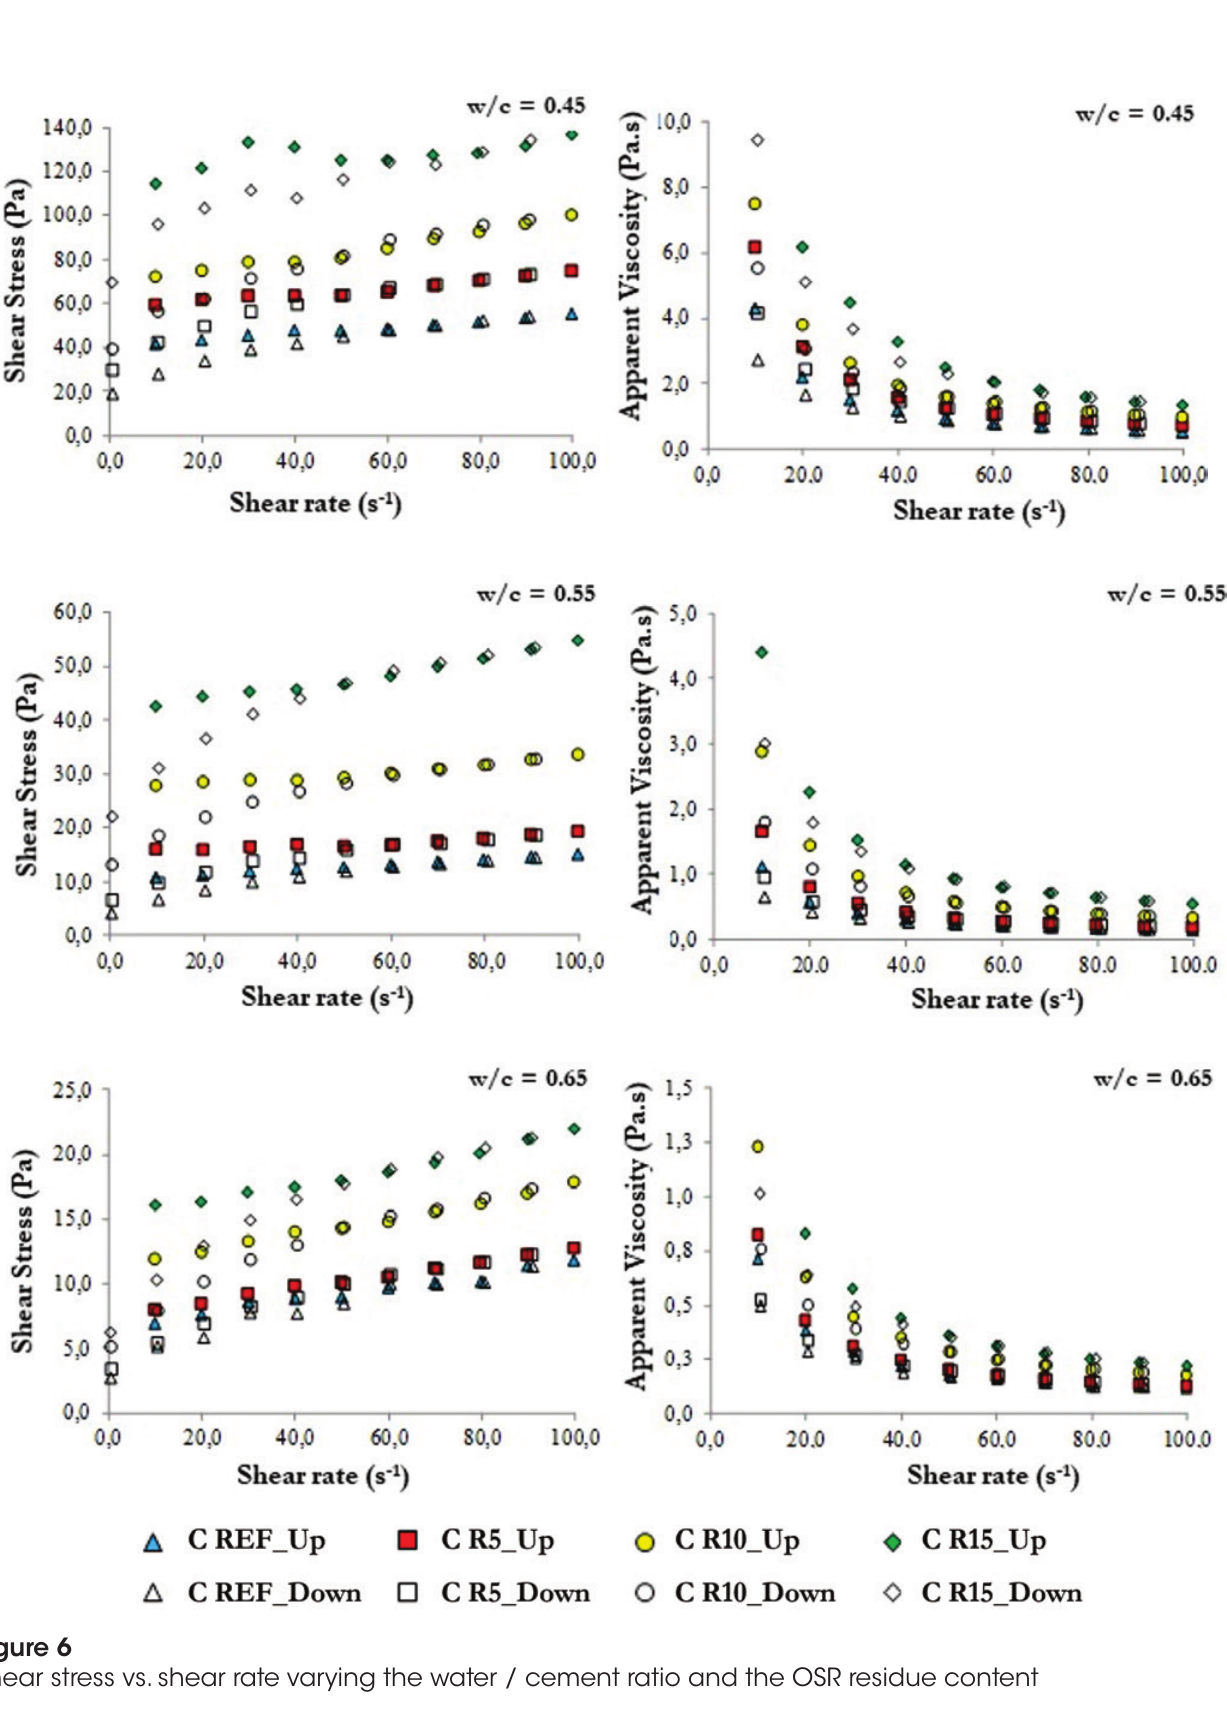
Figure 6 Shear stress vs. shear rate varying the water / cement ratio and the OSR residue